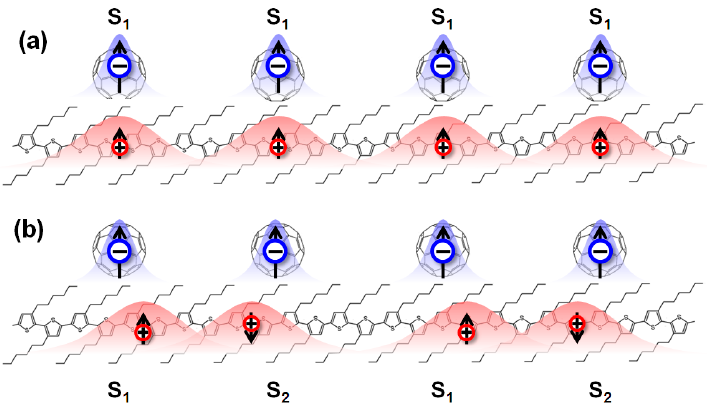
Figure 24. Schematic diagram of exciton coupling configuration of organic compounds. Schematic diagrams of ( a ) only triplet or EX1 excitons in parallel configuration, and ( b ) alternative EX1 and EX2 configuration.